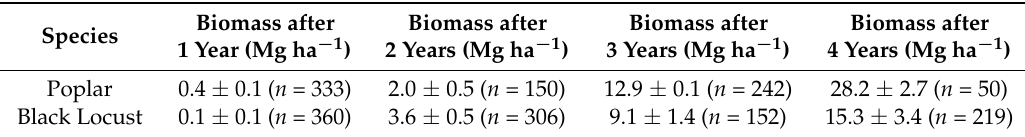
Table 1. Mean ( ± standard deviation) dry woody biomass for poplar and black locust trees with respect to the planting density and number of samples ( n ).